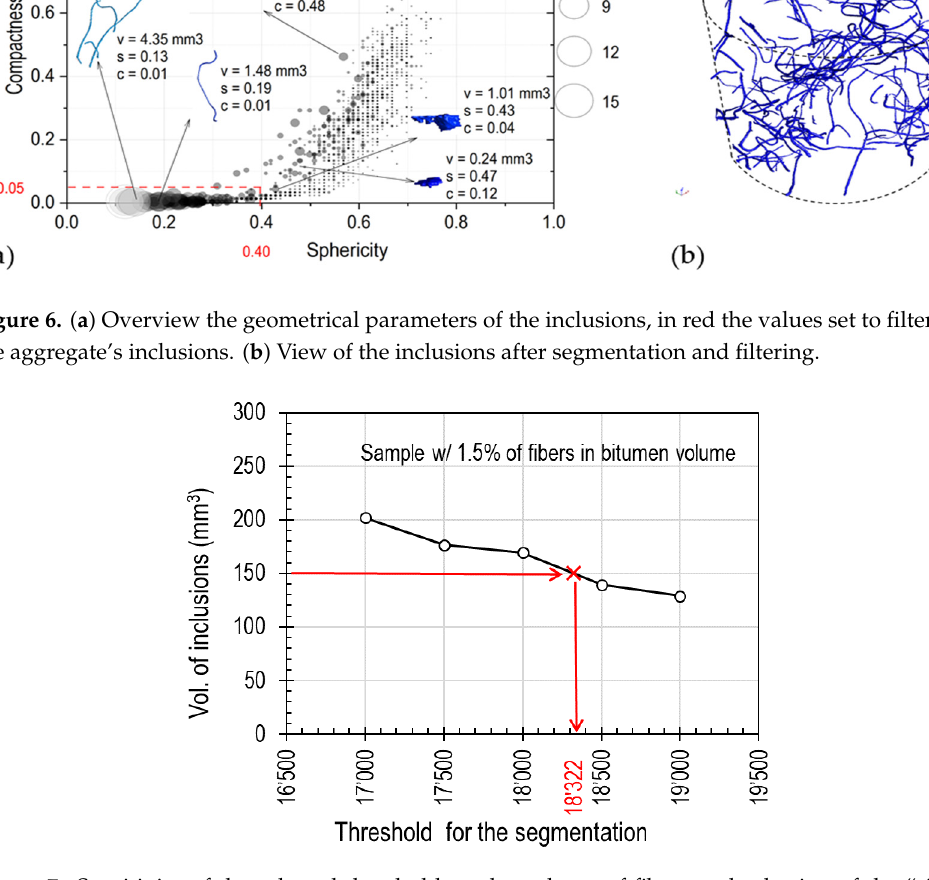
Figure 7. Sensitivity of the selected threshold on the volume of fibers and selection of the “right” threshold based on the volume of fibers recovered from the sample.